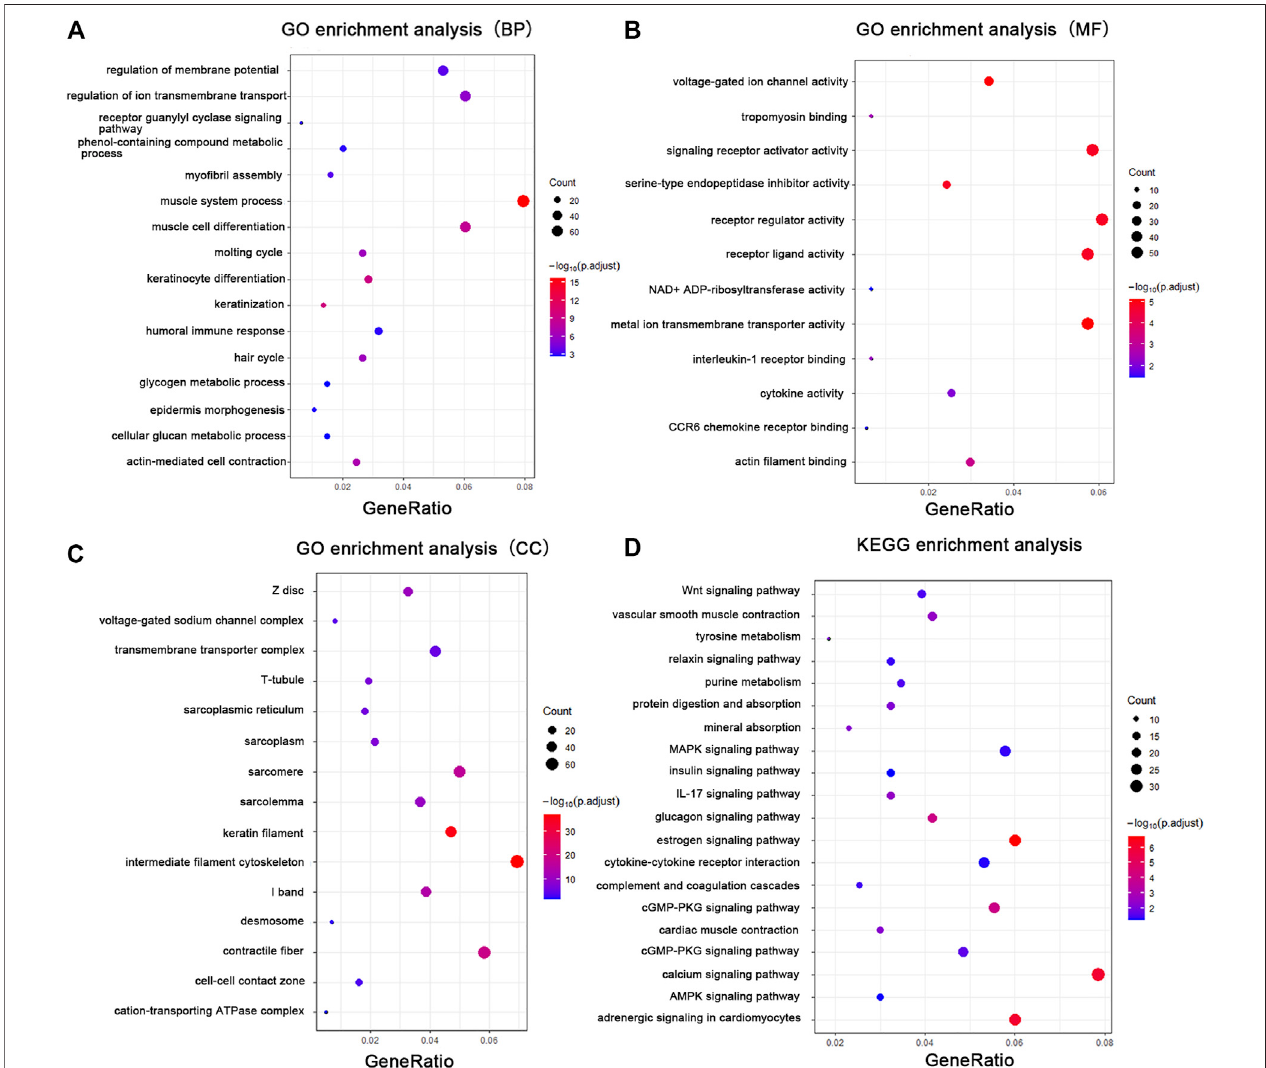
FIGURE 3 | GO enrichment analysis and KEGG analysis showed changes in the molecular response and signaling pathway changes of skin during tissue expansion. (A) GOenrichmentanalysisoftheDEGs inbiologicalprocesses. (B) GOenrichmentanalysisoftheDEGs inmolecularfunctions. (C) GOenrichmentanalysis oftheDEGsincellularcomponents. (D) KEGGanalysisoftheDEGs.GeneratioindicatesthenumberofDEGsassociatedwiththeGOtermdividedbythetotalnumberof DEGs.ThesizeofthedotsrepresentsthenumberofDEGsassociatedwiththeGOtermandthecolorrepresentsthenegativevalueoflog 10 ofadjustedp-value.BP biological processes, MF molecular functions, CC cellular